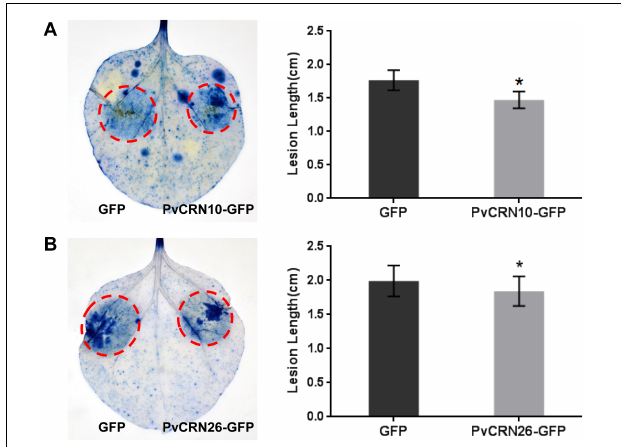
FIGURE 7 | PvCRN10 and PvCRN26 enhanced the resistance of N. benthamiana to P. capsici when transiently expressed in N. benthamiana. (A) Results for PvCRN10 , (B) Results for PvCRN26 . Left panel : representative inoculated N. benthamiana leaves stained with trypan blue. The lesions are outlined with red circles. Right panel : mean lesion lengths of N. benthamiana leaf regions that were expressing the control GFP plus either PvCRN10 or PvCRN26. The heights of rectangles represent the mean lesion lengths. Error bars represent SD of 9–12 samples. Asterisks indicate significant differences from the control groups (paired t -test; * p < 0.05). Similar results were obtained in three independent